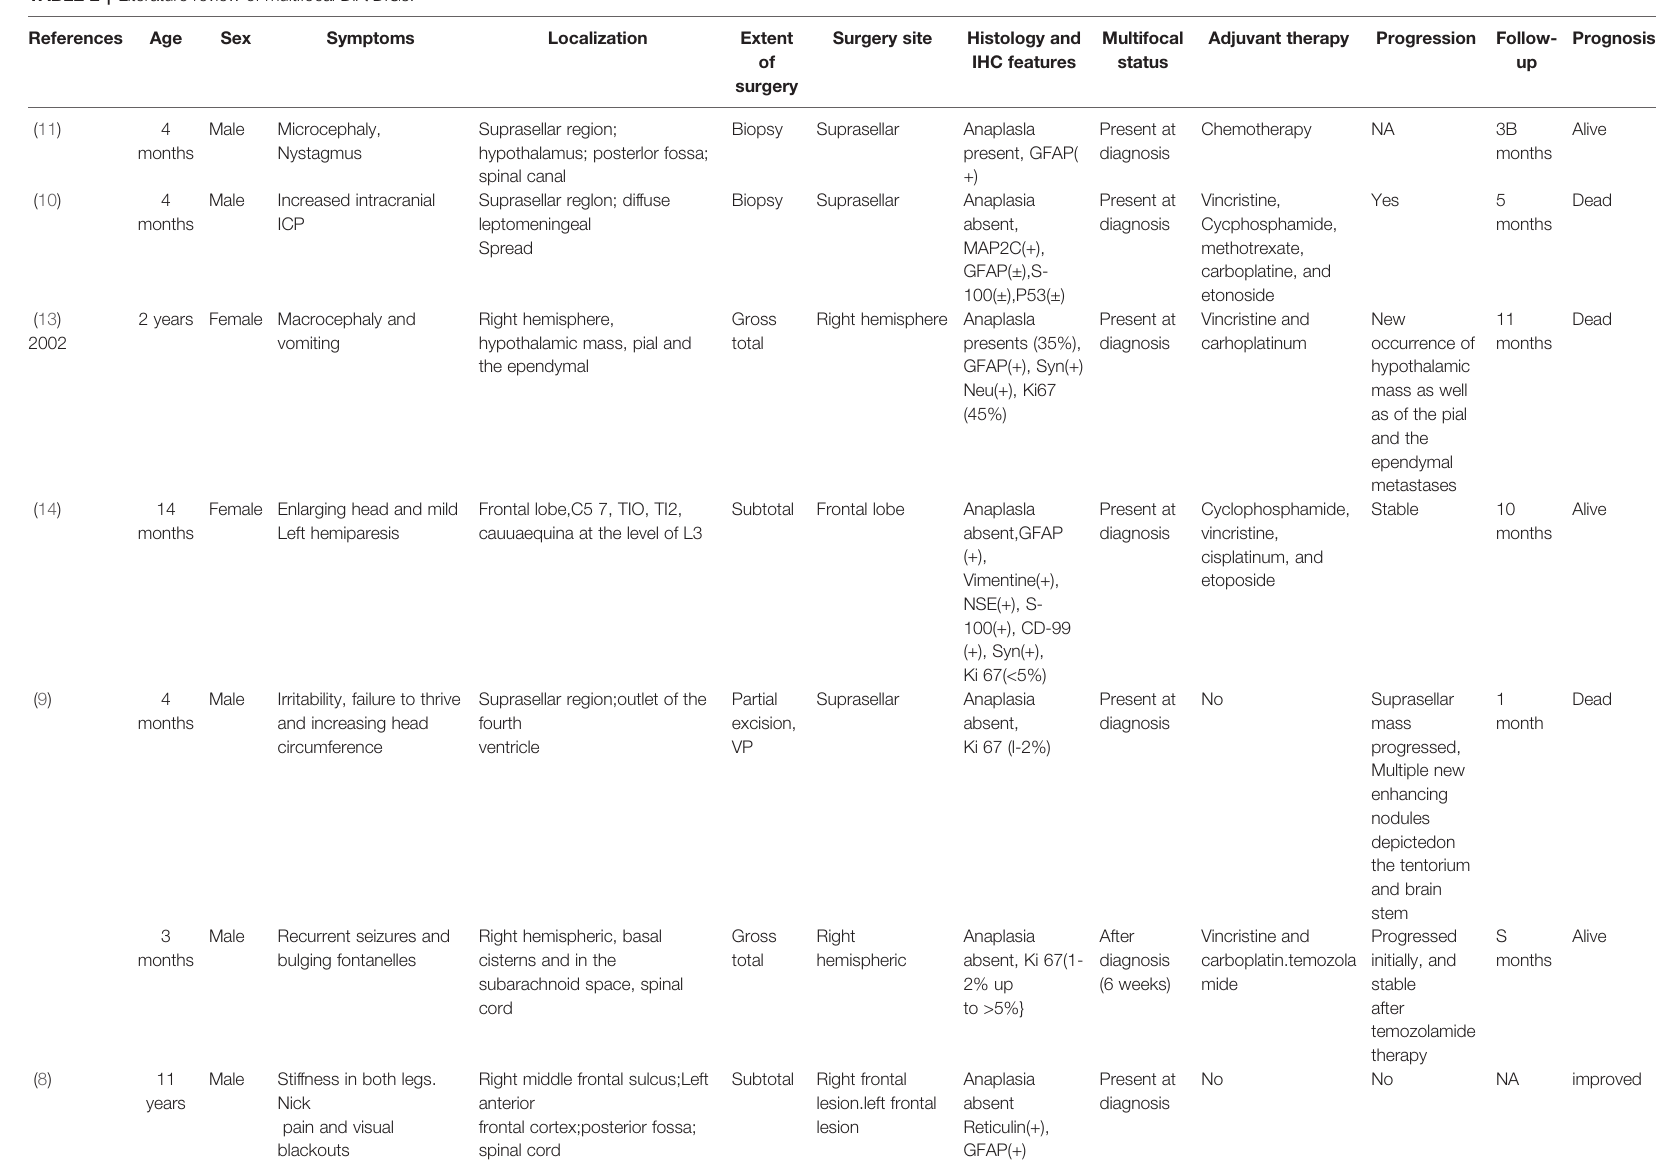
TABLE 2 | Literature review of multifocal